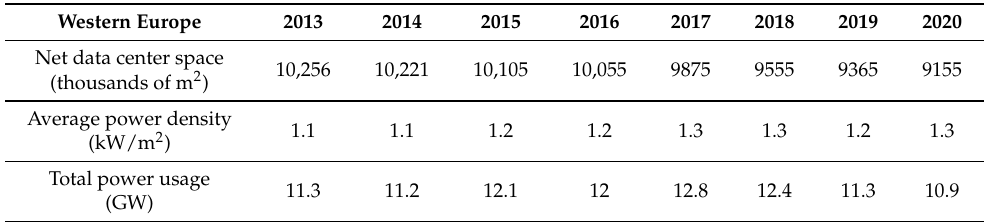
Table 1. Decreasing energy consumption in